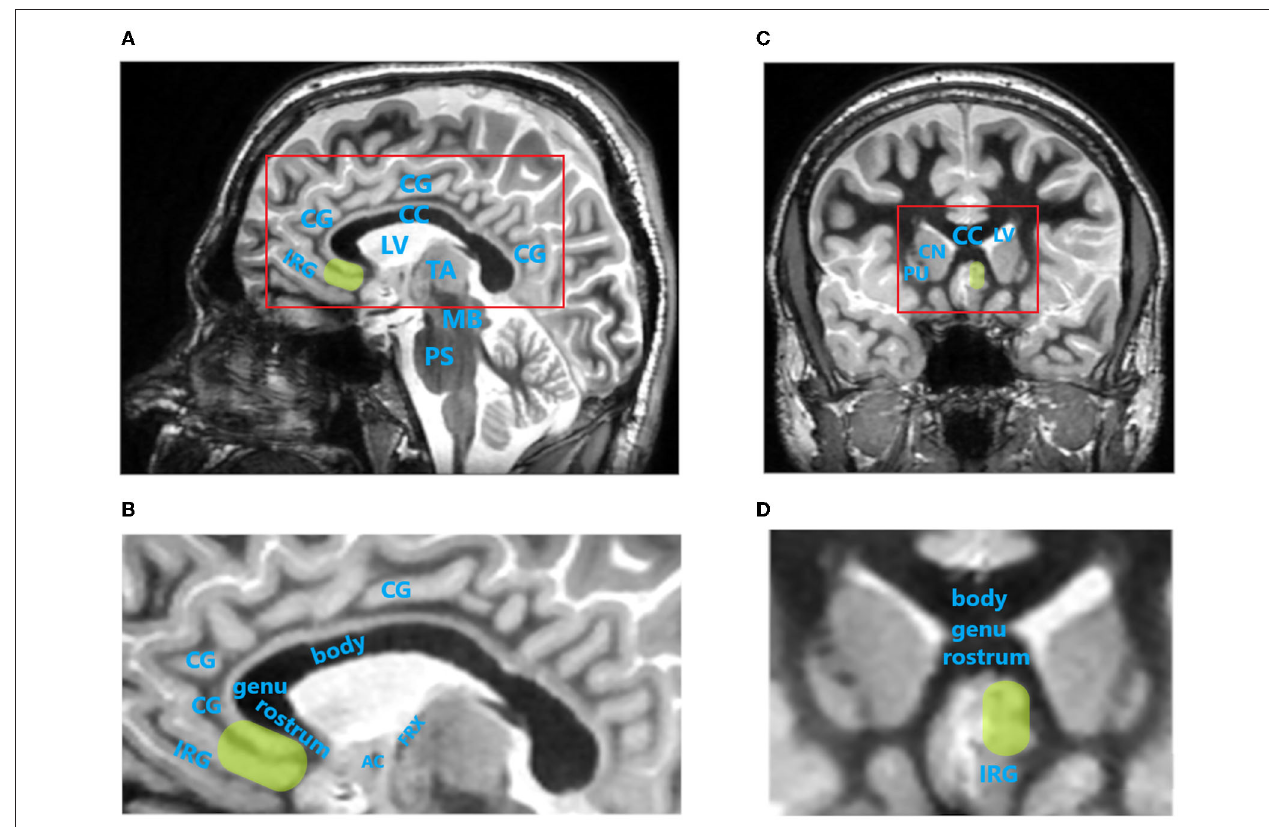
FIGURE 2 | Localization of the subcallosal cingulate cortex (SCC) by magnetic resonance imaging (MRI) using Fast Gray Matter Acquisition T1 Inversion Recovery (FGATIR) sequence. SCC is indicated by green oval region. (A) , Paracentral image of sagittal brain MRI scan. Red rectangle indicates brain region magnified in (B) . (B) , Magnified sagittal MR image of cingulate cortex region. (C) , Image of coronal brain MRI scan at the level of SCC. (D) , Magnified coronal MR image of cingulate cortex region. AC, anterior commissure; body, body of corpus callosum; CC, corpus callosum; CG, cingulate gyrus; CN, caudate nucleus head; genu, genu of